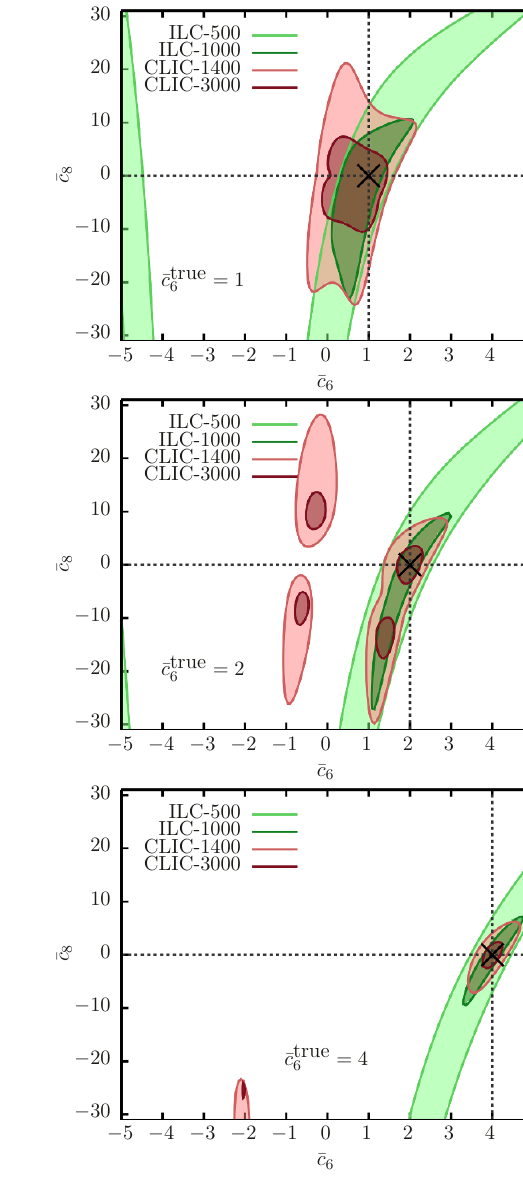
Figure 16 . Combined 2 (cid:27) bounds in the ((cid:22) c 6 ; (cid:22) c 8 ) plane assuming BSM cross sections corresponding ; (cid:22) c true to ((cid:22) c true = 0) in the Scenario 2 described in the text, with (cid:22) c true 6 8 in the plots with a